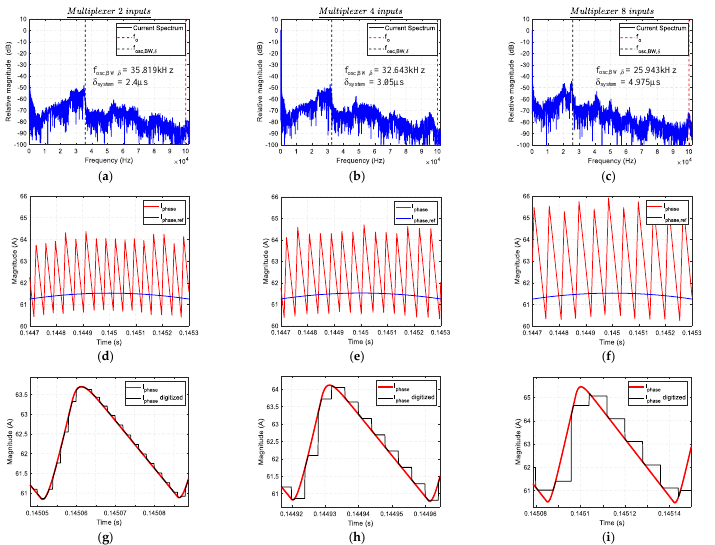
Figure 13. Effect of multiplexing of ( a , d , g ) 2 inputs, ( b , e , h ) 4 inputs and ( c , f , j ) 8 inputs on the current controlled by DPSSOCC. ( f sw , ADC = 5 MHz, f sw , F 2 = 1 MHz, f o = 100 kHz and ξ = 1). The spectra presented validate the accuracy of Equation (12). The use of a multi- plexer does not affect the quality of the current as long as the switching frequency of the multiplexer is sufficiently high and its number of inputs is relatively low. In other words, the model is inaccurate if the loss of information due to multiplexing is too important. 3.5.4. Miscellaneous Issues Among the multiple causes of time delays not discussed so far, two can be high- lighted. On the one hand, the z-transform method used affects the phase rotation pro- vided by the digital filter in comparison with the behavior of an analog filter. Indeed, the choice of the z-transform method used for the passage from the time domain to the fre- quency domain generates more or less large errors. Table 2 illustrates the additional time delay for a digital second order low-pass filter sampled at 1 MHz for the mains z – transforms. Table 2. Mains z-transforms and resulting time delays after 2 nd order low-pass filter discretization. Z-Transform Method